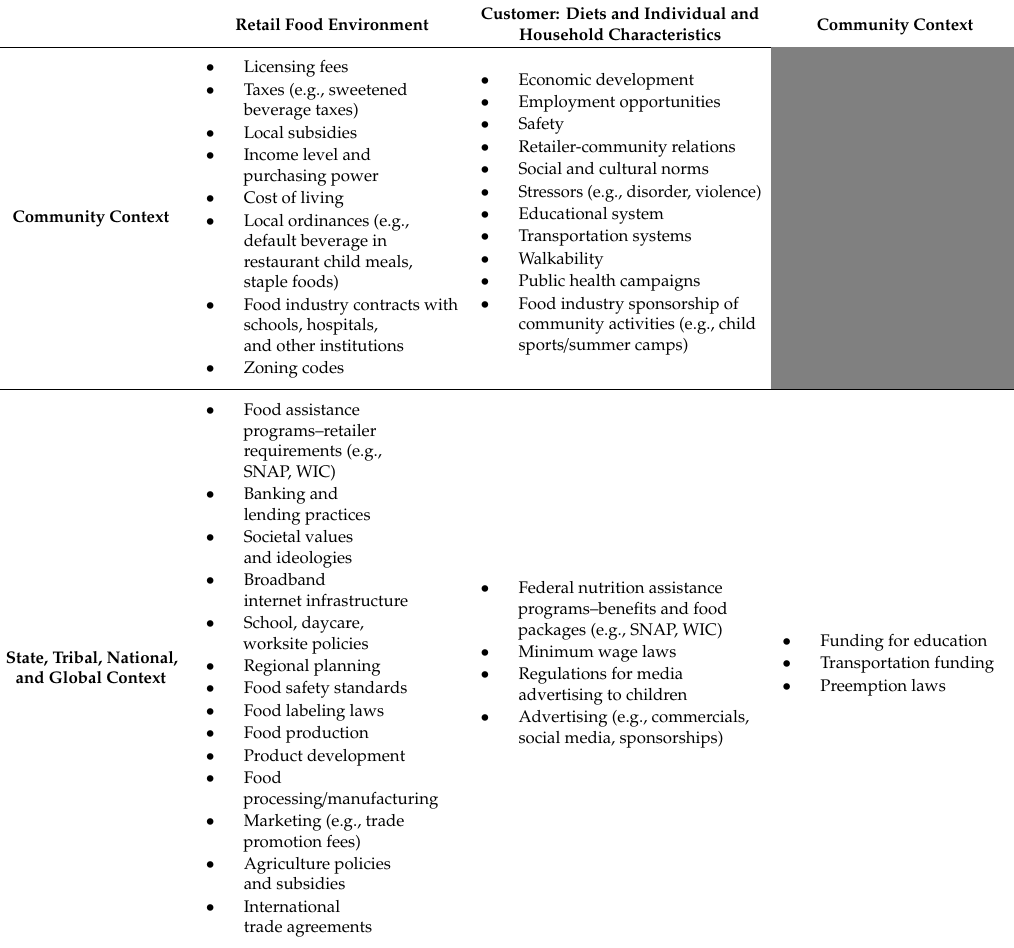
Table 3. Macro-level contexts with example factors that influence the retail food environment; customer purchasing, dietary intake, and individual and household characteristics; and their